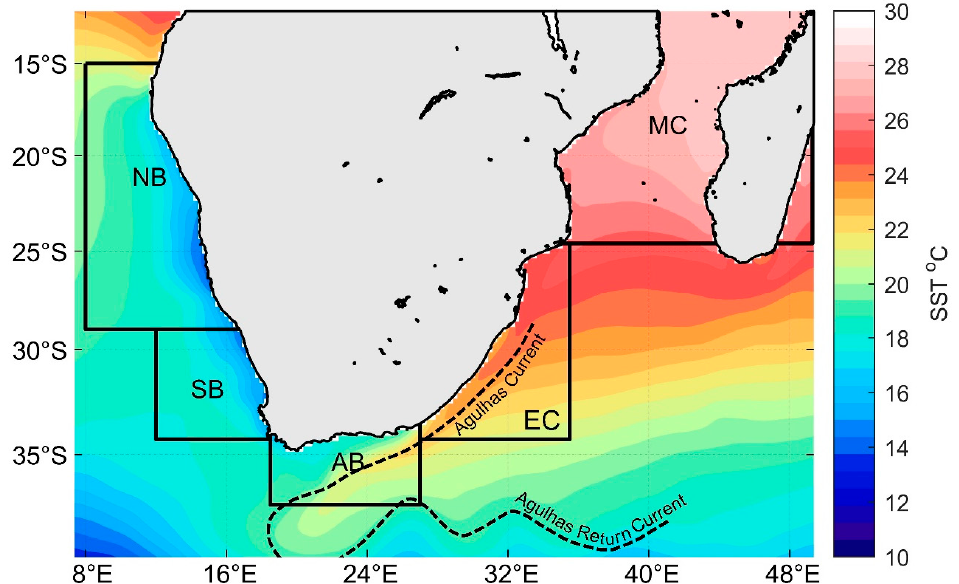
Figure 1. Mean Sea surface temperature (SST) from AVHRR_OI SST (2 September 1981 to 23 April 2019). The black boxes represent the five sub regions. The abbreviations NB, SB, AB, EC and MC indicate the northern Benguela, southern Benguela, Agulhas Bank, East Coast and Mozambique Channel, respectively. The dashed black line is a schematic of the Agulhas Current system depicting the Agulhas Current and Agulhas Return Current.